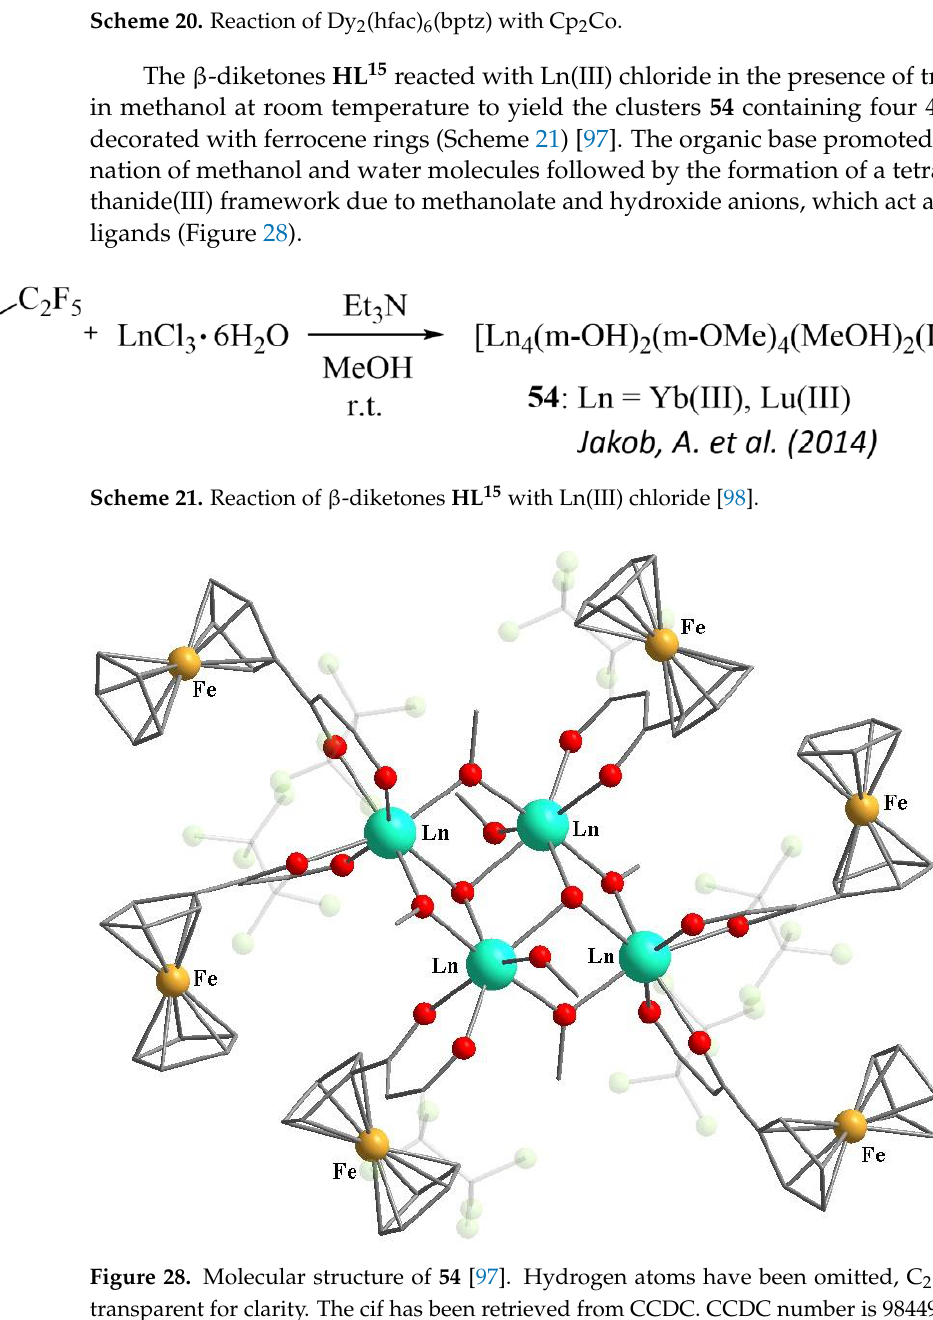
parent for clarity. The cif has been retrieved from CCDC. CCDC number is 984498.